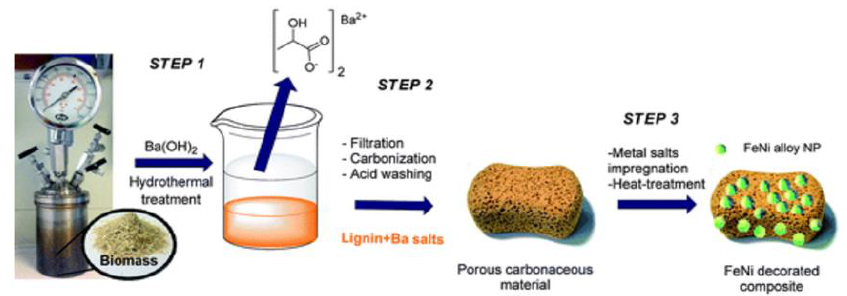
Figure 10. Process involved in the synthesis of FeNi NPs-supported carbonaceous material composite derived from porous lignin. Adapted with permission from ref. [36].